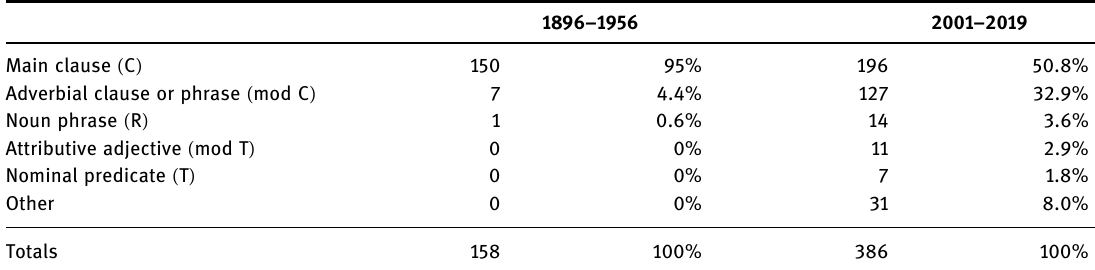
Table 2: Scope variation of dizque : Colombian diachronic